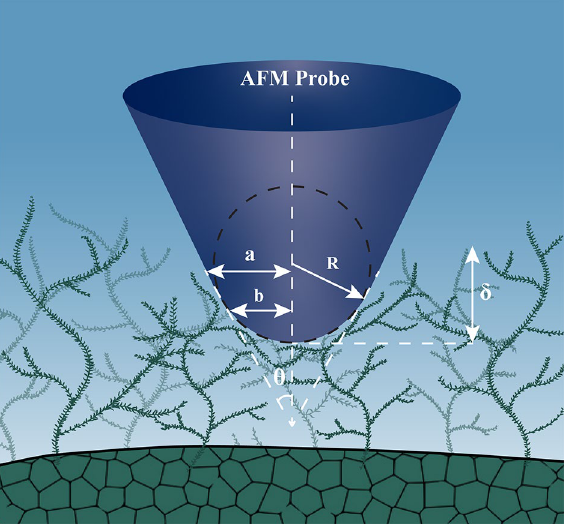
Figure 2. Schematic of the contact geometry of a rigid cone with a spherical tip indenting the lehfilcon A contact lens material with a branched polymer-brush surface